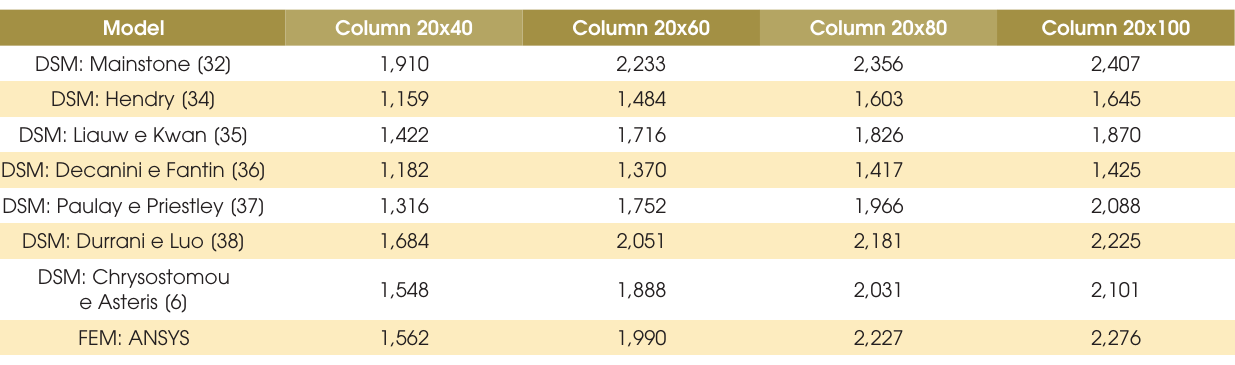
Table 5 – Interstorey drifts – values in